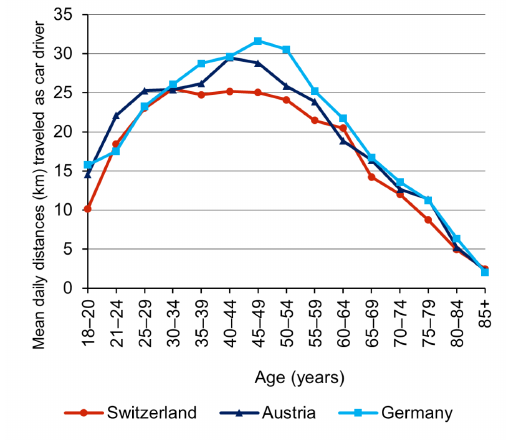
Figure 1: Mean daily distances (km) travelled as car drivers on the day(s) of reference by country and age group, based on national mobility survey data (see table 1). When calculating the mean val- ues, persons with no driving exposure on the reporting date were also considered.